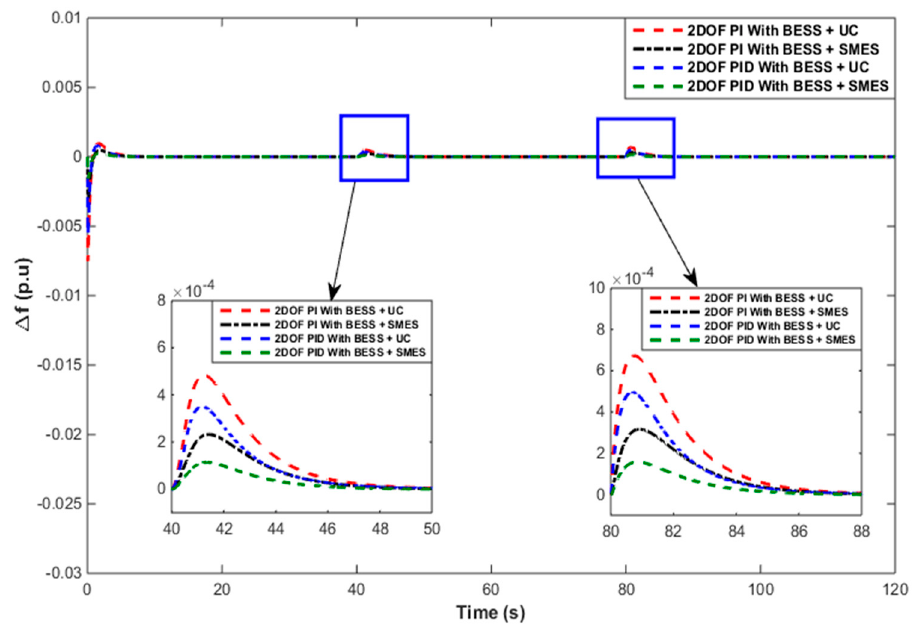
Figure 19. Comparative performances of the frequency responses of BESS + UC (case 2) and BESS + SMES (case 3) with the FPA-optimized 2DOF-PI- and 2DOF-PID-controller-based hybrid energy systems.